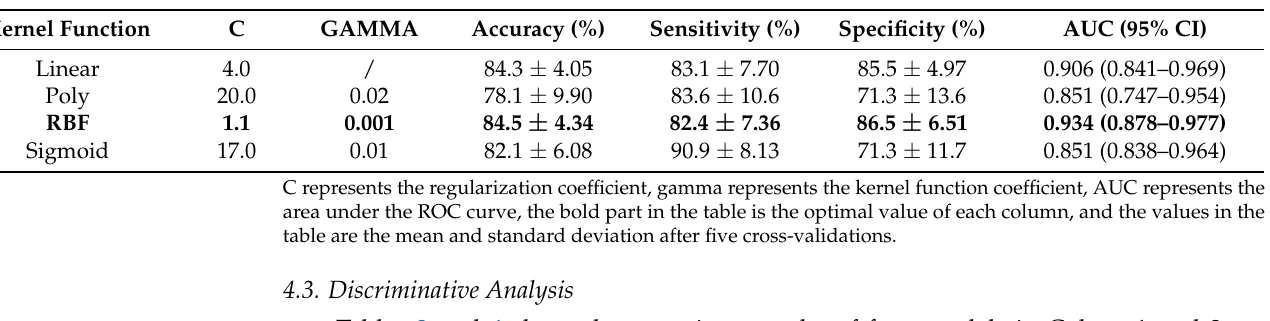
Table 2. The optimized hyper-parameters of SVM in test dataset.